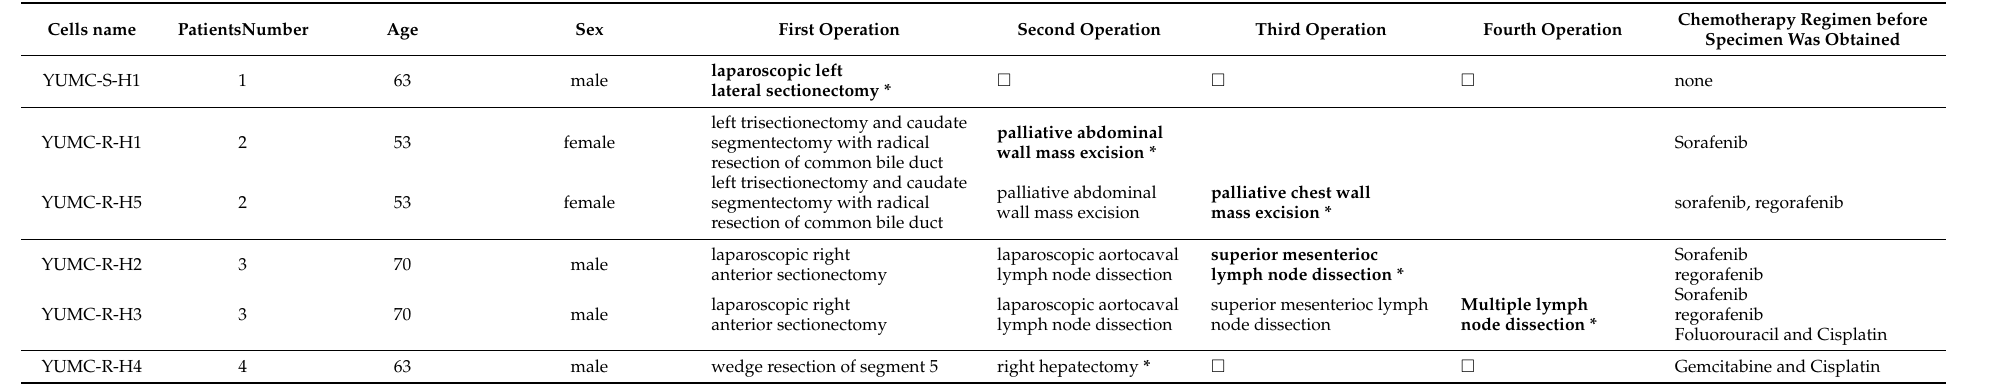
Table 1. Sample data from patients with hepatocellular